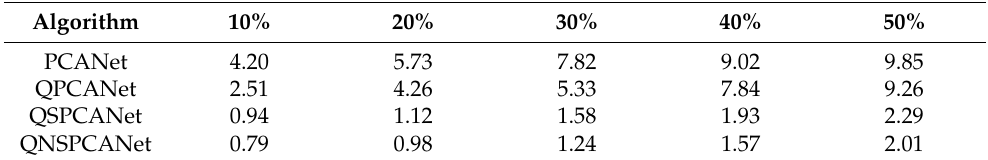
Table 6. Root mean square error of five recognition algorithms under different salt-and-pepper noise occlusion area (%).